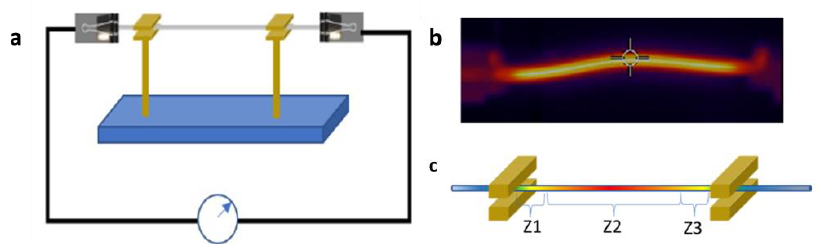
Figure 1. ( a ) Experimental setup for resistive heating growth. ( b ) Thermographic image of a wire. The cross indicates the point at which the maximum temperature is measured. ( c ) Sketch of the three zones established for the characterization of the core–shell structures grown.